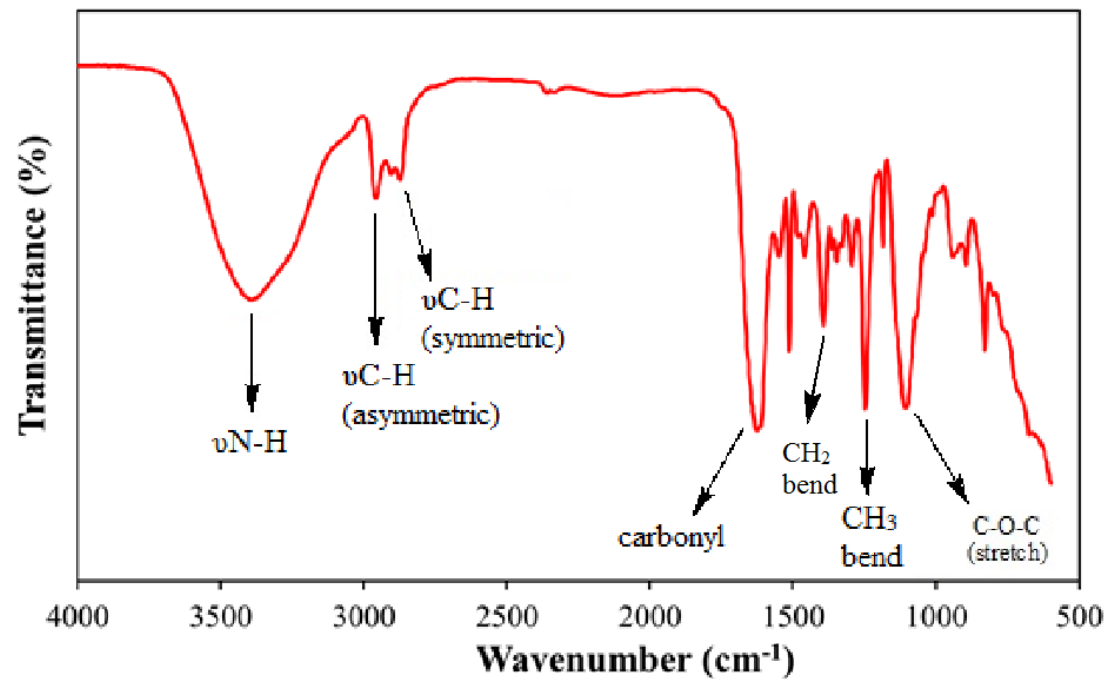
Figure 4. Fourier-transform infrared spectroscopy (FTIR) of TEAC. Table 3. FTIR data of the zwitterionic surfactants.